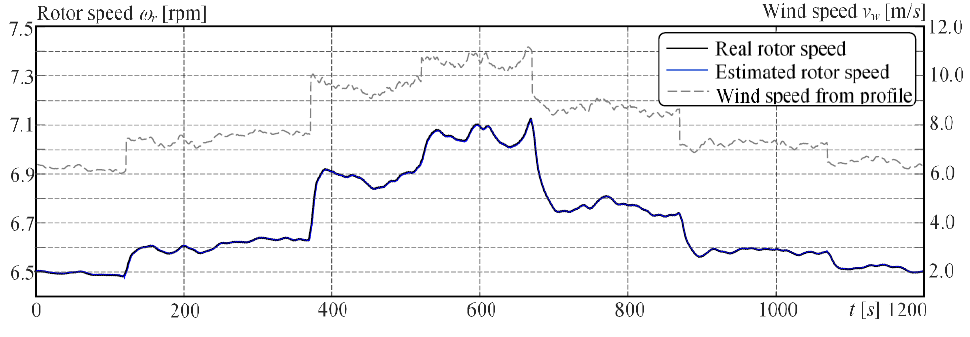
Table 4. Quantitative evaluation of the model and observer performance. Figure 14. Single-side amplitude spectrum of the shaft twist angle. Figure 14. Single-side amplitude spectrum of the shaft twist angle.